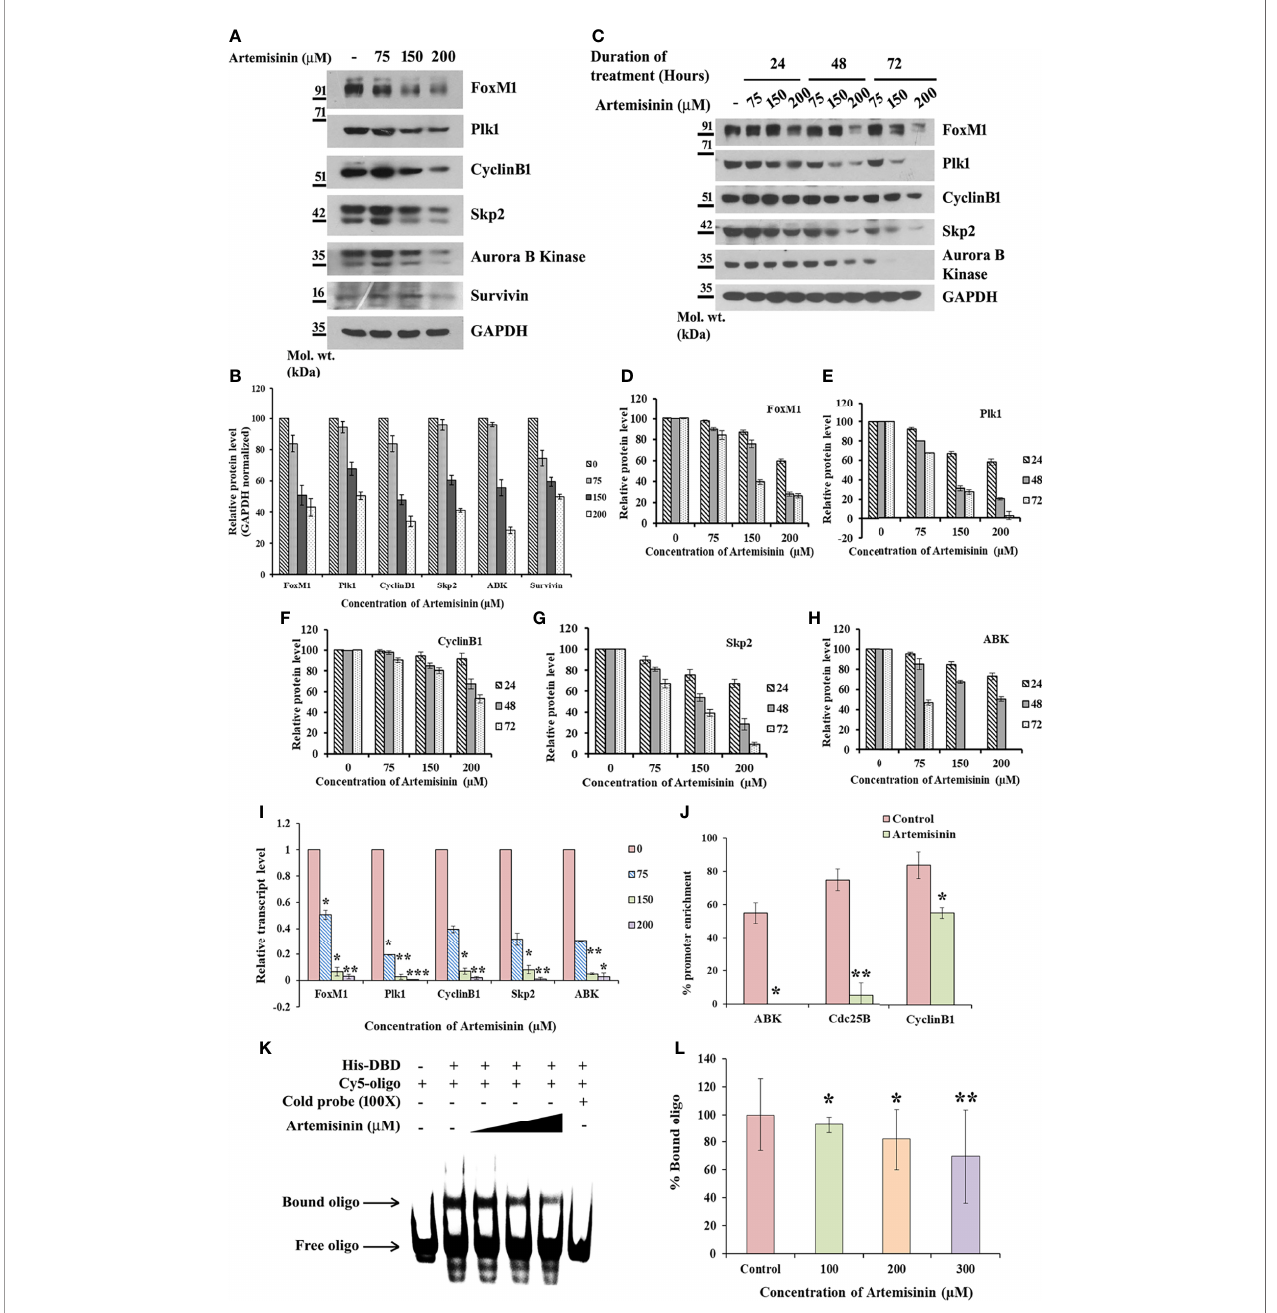
FIGURE 2 | Artemisinin impedes FoxM1 transcriptional activity. (A) Equal amounts of HepG2 cell lysates treated with Artemisinin for 48 h were subjected to SDS- PAGE and immunoblotting using antibodies speci fi c for FoxM1, Plk1, CyclinB1, Skp2, Aurora B Kinase and Survivin. GAPDH was used as a loading control. (B) Densitometric analysis of the relative protein levels of FoxM1 antibody and its targets using ImageJ, normalized to GAPDH. (C) HepG2 cells were treated with Artemisinin for 24, 48 and 72 h followed by SDS-PAGE and western blotting for FoxM1 and its downstream effectors with GAPDH as a loading control. (D – H) Graphical representation of the relative protein levels of FoxM1 and its targets quanti fi ed using ImageJ. (I) Total RNA was isolated from HepG2 cells treated with Artemisinin using TriZOL. qRT-PCR was performed using SYBR Green assay. The fold mRNA change has been represented graphically, normalized to GAPDH. (J) HepG2 cells were treated with 100 µM Artemisinin for 24 h followed by ChIP using anti-FoxM1 anti-body and PCR with gene-speci fi c primers. GAPDH served as an internal control. The percent promoter occupancy by FoxM1 is represented graphically. (K) Puri fi ed FoxM1-DBD was mixed with the Cy5-labeled DNA probe and Artemisinin added to the reaction in increasing concentrations. Representative EMSA image is shown. (L) Quanti fi cation of the percent bound oligo is presented. * p < 0.05, ** p < 0.01, and *** p < 0.001. All data are expressed as the means ± standard deviations from triplicate experiments. The two-tailed Student ’ s t -test was used to determine whether the differences between vehicle-treated set and Artemisinin-treated set were signi fi